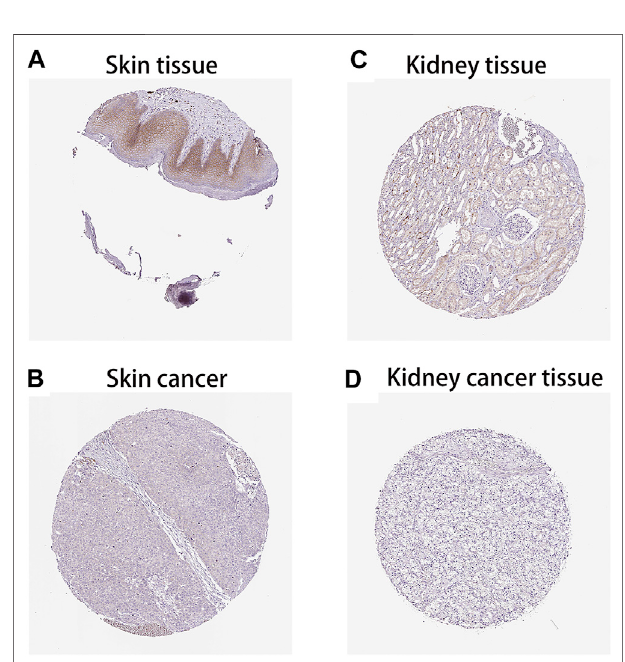
FIGURE 4 | Protein levels of FAM46C in tumour and normal tissues from the Human Protein Atlas (HPA) database. (A,C) Normal skin and kidney tissues, respectively. (B,D) Skin and kidney cancer tissues,